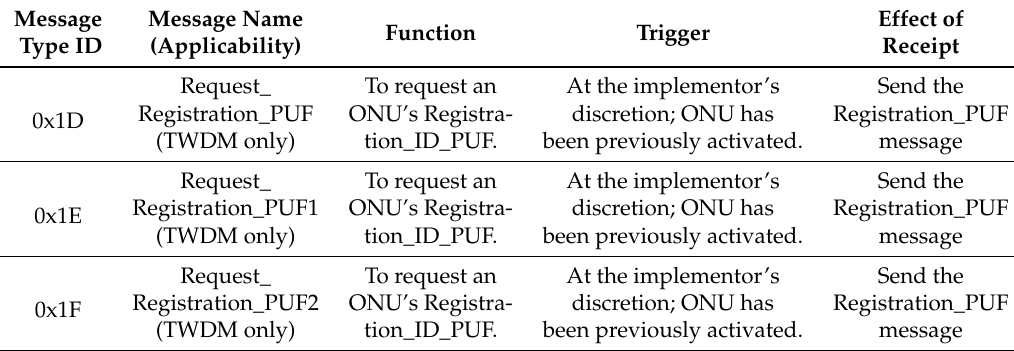
Table 1. New downstream physical layer operations, administration, and maintenance (PLOAM)